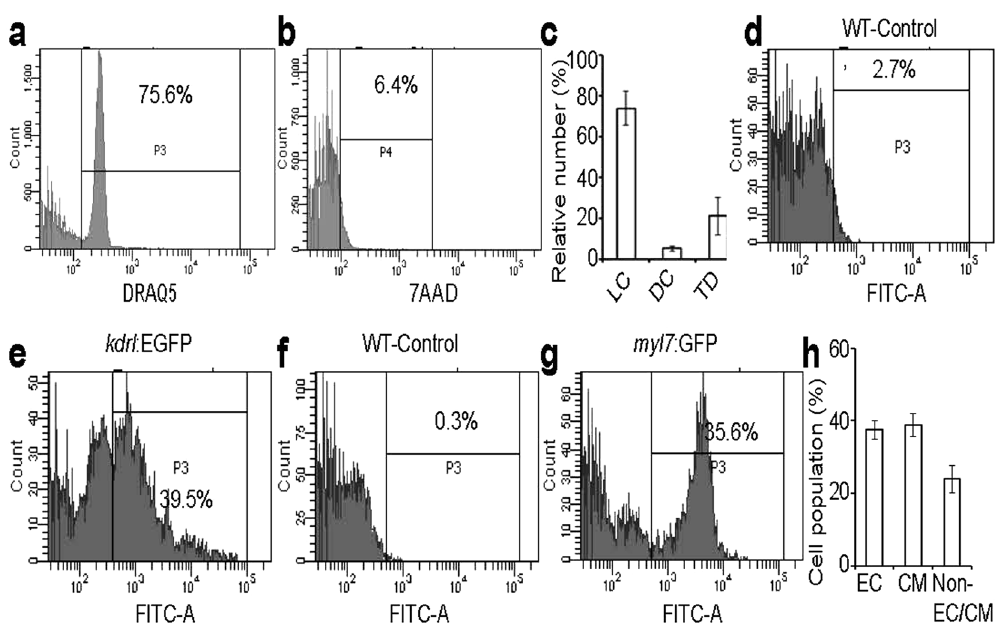
Figure 2. Flow cytometry analysis of cells isolated from adult zebrafish ventricles. ( a–g ) Live cell fraction ( a ), dead cell fraction ( b ), quantitative analysis of live cells (LC), dead cells (DC), and tissue debris fraction (TD) in the cell preparation samples (n = 3, mean ± SEM) ( c ), EGFP positive (endothelial cells) fraction in DRAQ5 positive live cell population of WT and Tg(kdrl:EGFP) fish ventricles ( d,e ), and EGFP positive (cardiomyocytes) fraction in DRAQ5 positive live cell population of WT and Tg(myl7:EGFP) fish ventricles ( f,g ). ( h ) Quantification of different cell types; endothelial cells (EC) and cardiomyocytes (CM) constituted 37.36 ± 2.49% and 38.80 ± 3.17% of the DRAQ5 positive cell population originating from cardiac ventricles, respectively (n = 3, mean ± SEM). WT- wild-type